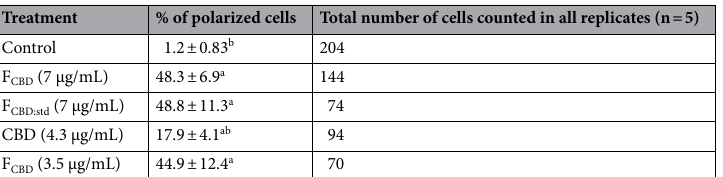
Treatment % of polarized cells Total number of cells counted in all replicates (n = 5)